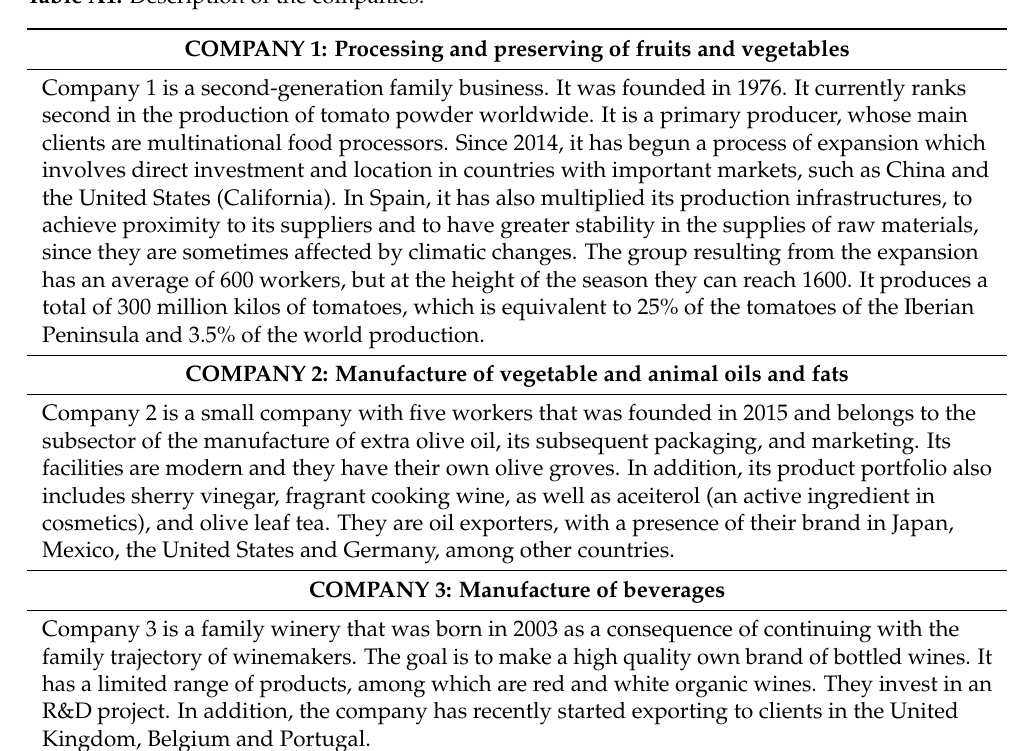
Table A1. Description of the